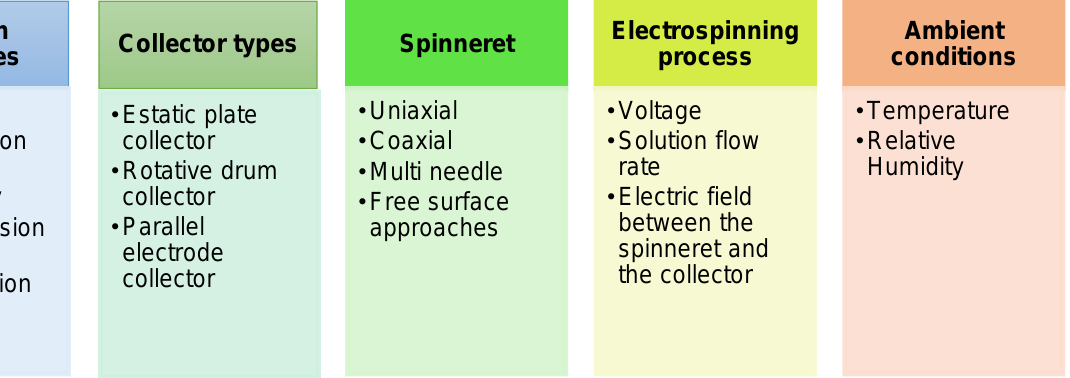
Figure 2. A summary of key parameters affecting the electrospinning process based on the knowledge described in the following references [25,28,37,39,47,52,53].